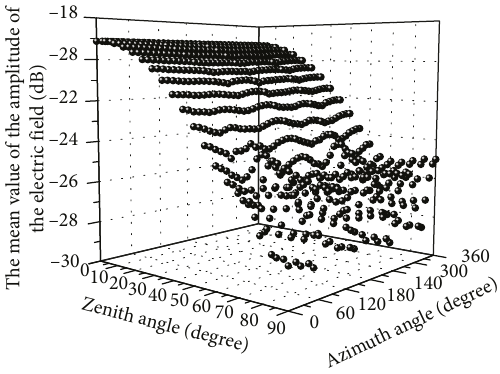
Figure 11: The mean value of the amplitude of the electric fi eld for di ff erent inclination angles in the LOS corridor (scatter diagram).